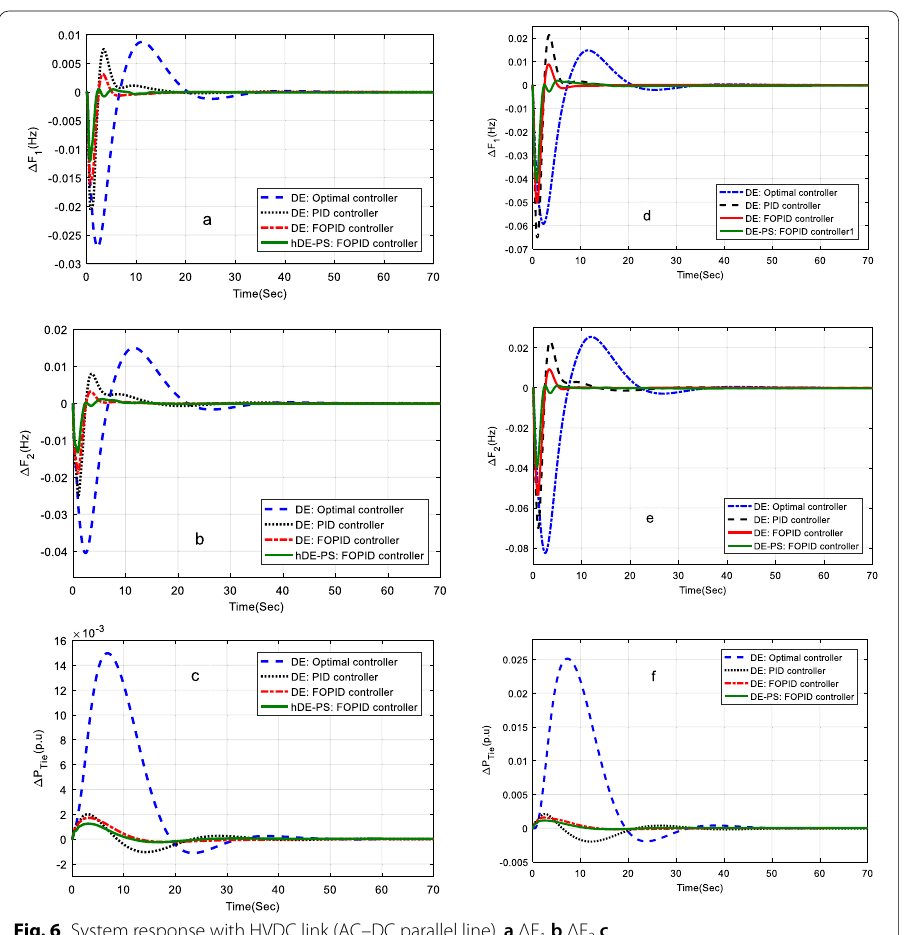
Fig. 6 System response with HVDC link (AC–DC parallel line). a ΔF 1 b ΔF 2 c